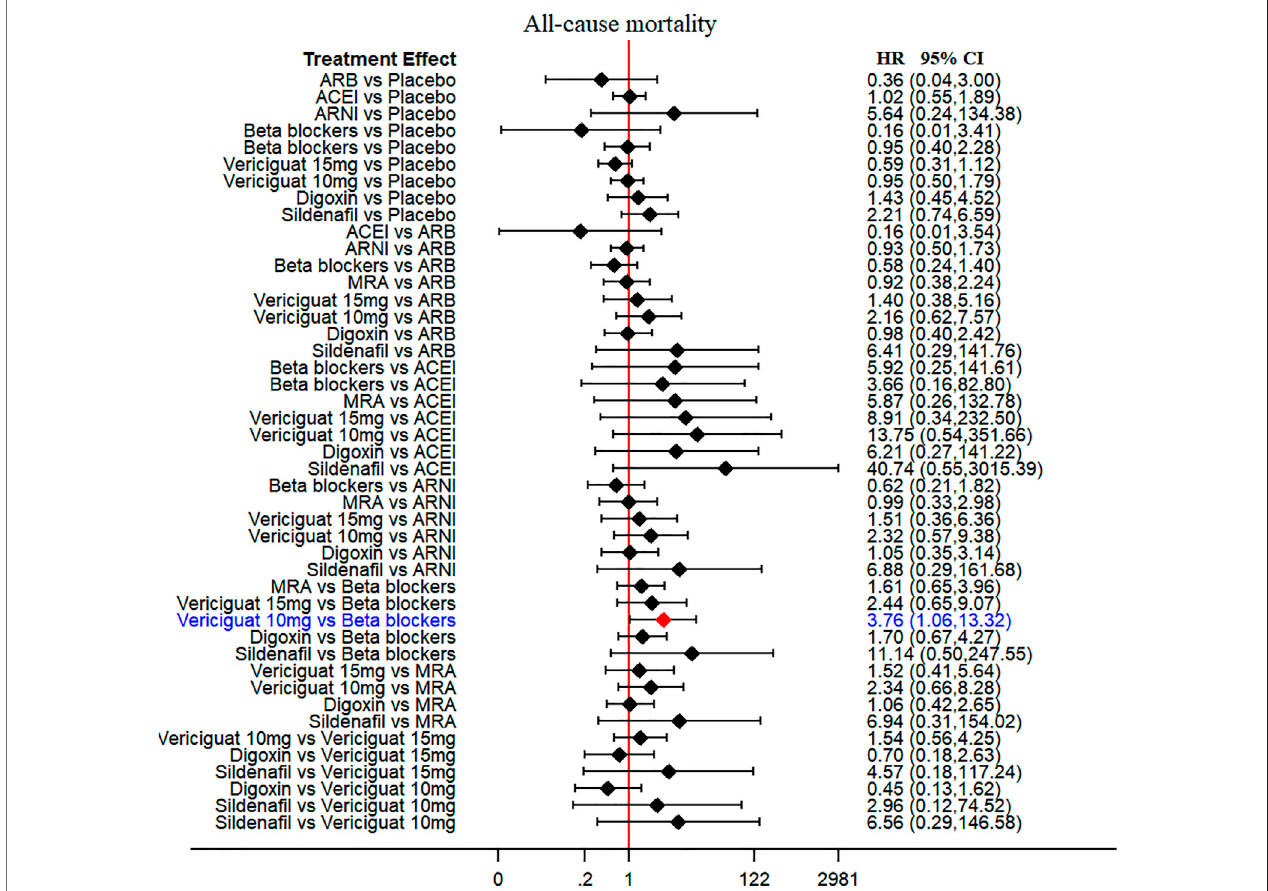
FIGURE2| Drug strategies in theNetwork.Thewidth oflines between each drug re fl ects thenumber ofstudies available for each comparison. ACEI, angiotensin- converting enzyme inhibitor; ARB, angiotensin receptor blocker; ARNI, angiotensin receptor neprilysin inhibitor; MRA, mineralocorticoid receptor antagonist.